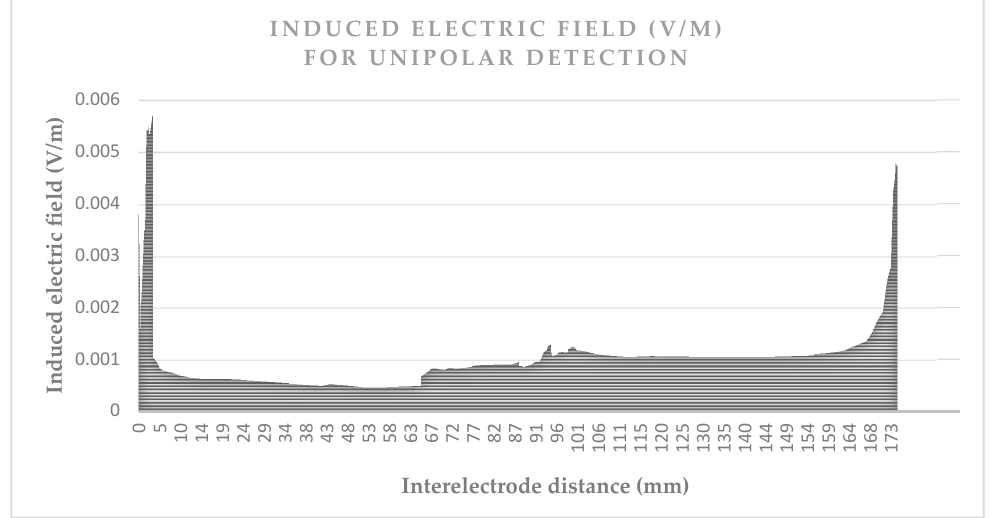
Figure 3. Induced electric field (V/m) between the electrodes (mm) in the unipolar detection of a pacemaker implanted to Ansoft 2 mm (grounded), due to the vertical electric field exposition (1 kV/m at 50 Hz). Bioengineering 2017 , 4 , 19